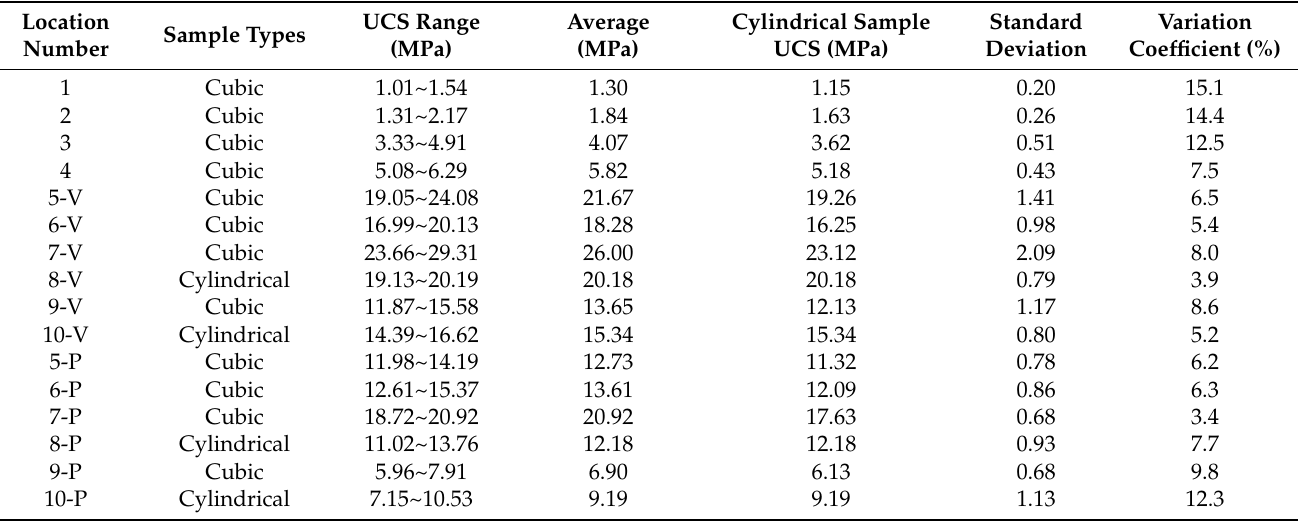
Table 3. Results of uniaxial compressive strength